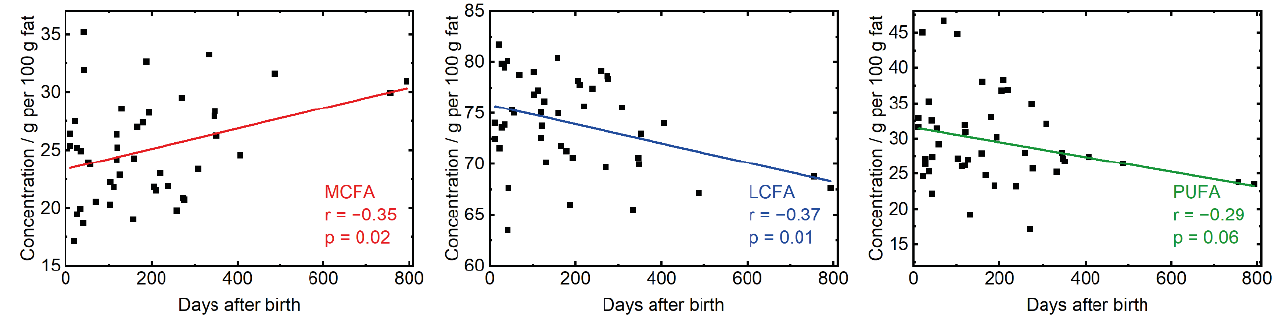
Figure 3. Concentration of medium-chain fatty acids (MCFA), long-chain fatty acids (LCFA), and polyunsaturated fatty acids (PUFA) determined with ATR-FTIR spectroscopy over the course of lactation.